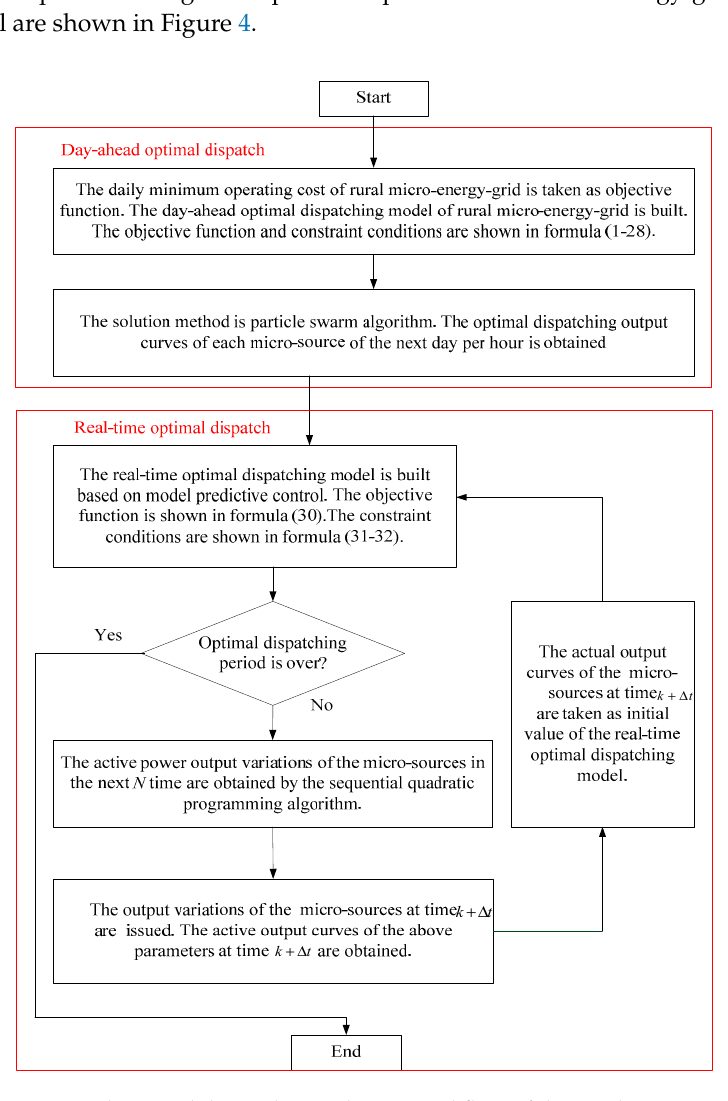
Figure 4. Integrated optimal dispatching solution workflow of the rural micro-energy-grid.